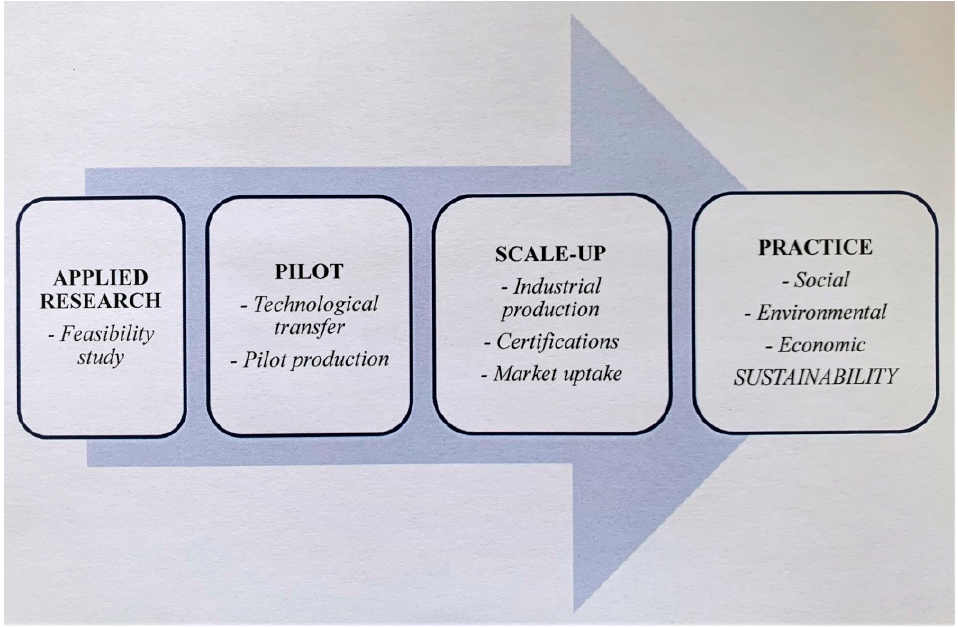
Figure 1. Conceptual scheme of the path towards ceramic tiles with a high content of recycled materials.